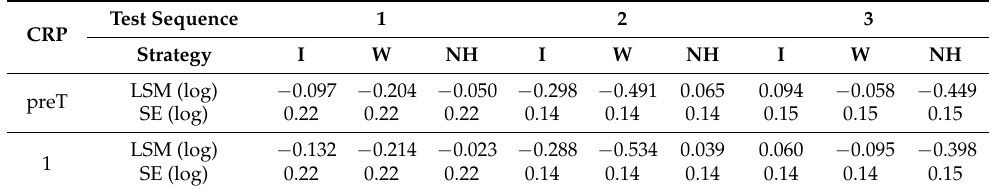
Table 18. Results for CRP [mg · mL − 1 ] measured before (preT) and one hour (1) after the test performed using different hydration strategies (I, W, BN) in three consecutive tests (1, 2, 3): marginal means (LSM) and standard errors (SE) for values after logarithmic transformation (log). Test Sequence 1 CRP